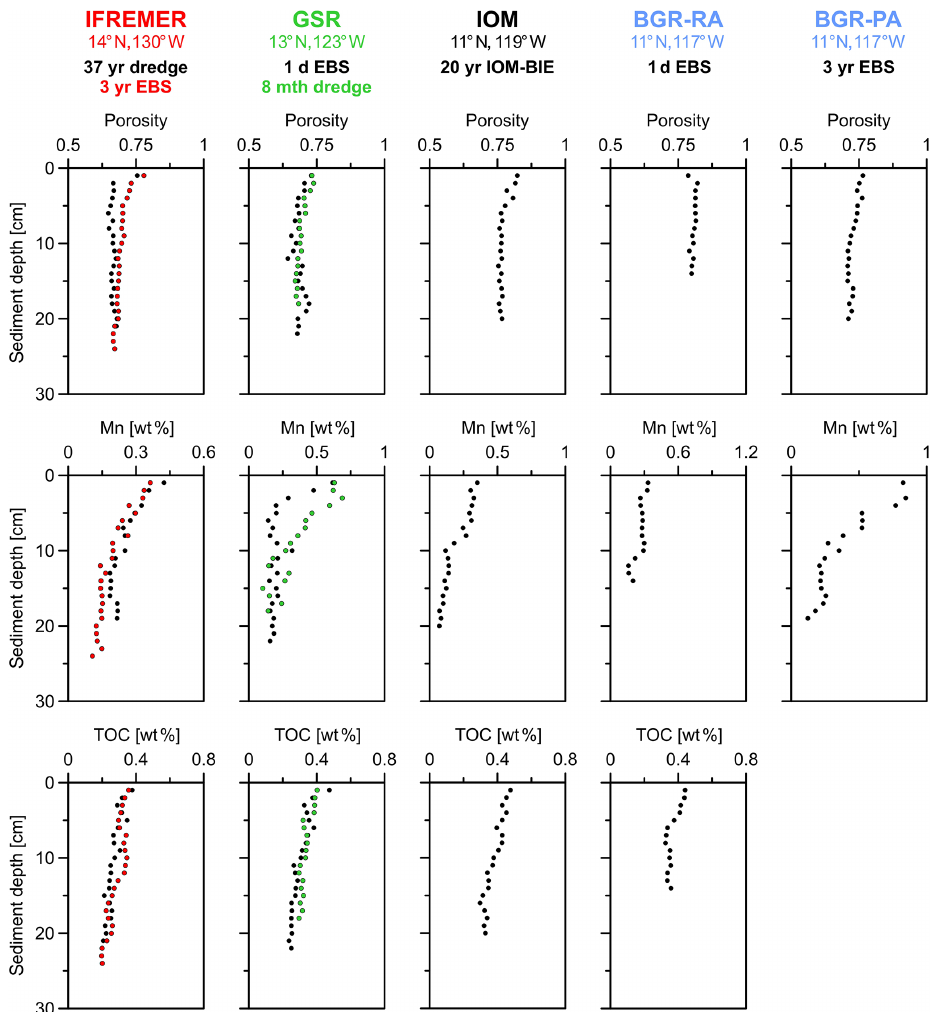
Figure 3. Solid-phase Mn and TOC contents for all disturbed sites investigated in the framework of this study (years: yr; months: mth; days: